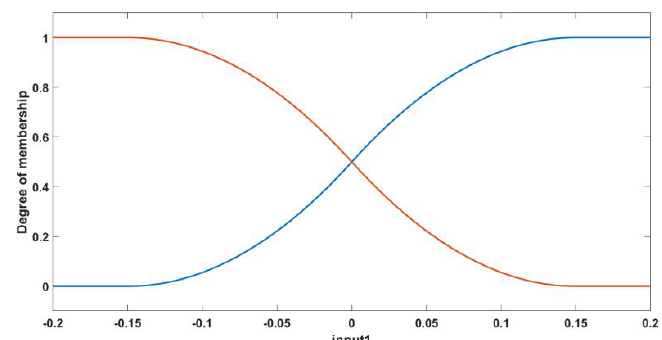
Figure 12. Membership functions.